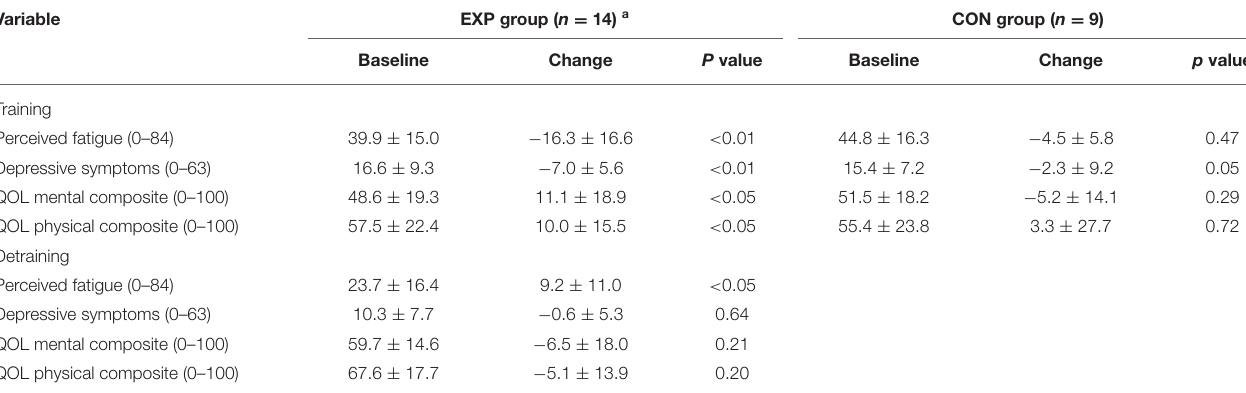
TABLE 3 | Baseline values, changes scores, and significance of change scores in both CON and EXP groups.